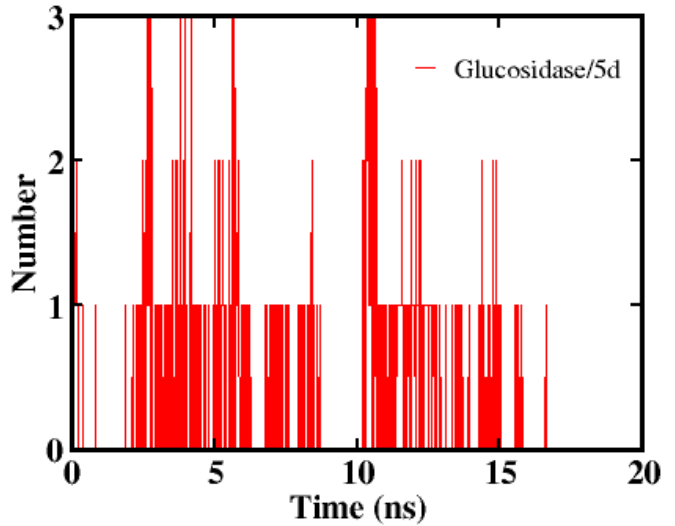
Figure 5. Average number of hydrogen bonds formed between α-Glucosidase and 5d during 20 ns simulation.